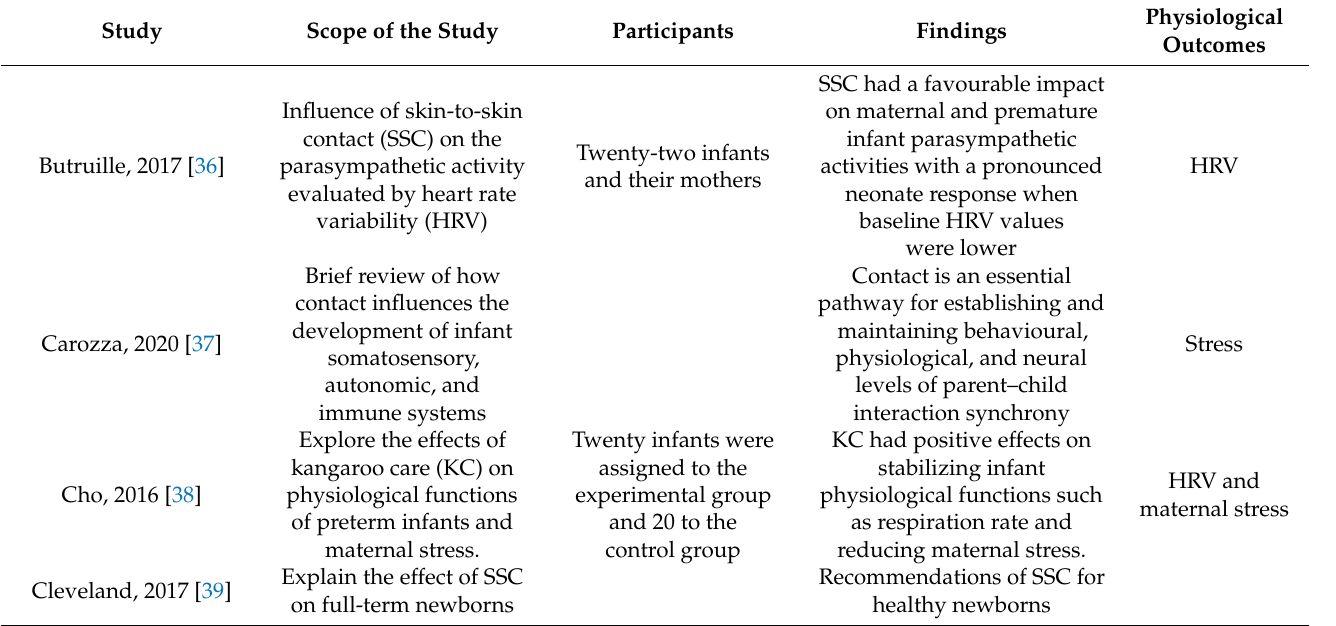
Table 1. Features of the studies